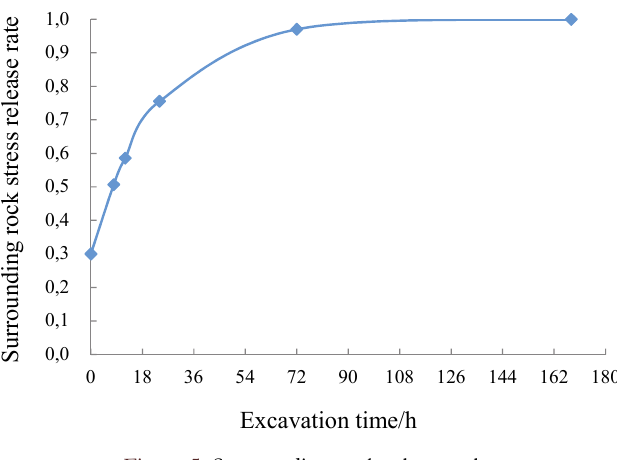
Figure 5: Surrounding rock release rules.